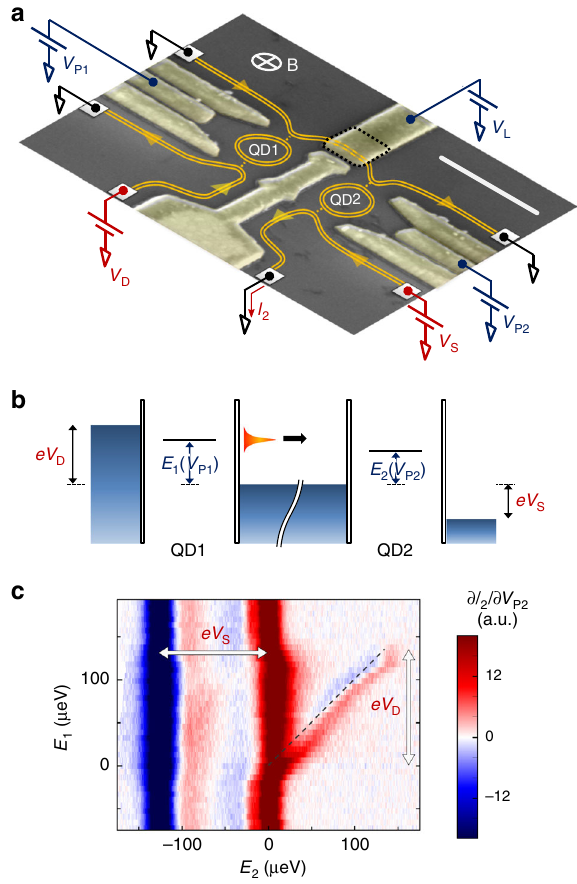
Fig. 1 Principle and implementation of the experiment. a False-color scanning electron micrograph of a typical sample. The ECs at ν = 2 are depicted in orange. The large ohmic contacts located away from the center of the sample are depicted by the gray squares. The white scale bar corresponds to 500 nm. b Energy-scale sketch of the experiment. The two QDs are depicted by a single resonance at energy E 1 ( V P1 ) and E 2 ( V P2 ), respectively. The emitted quasiparticles are depicted by the orange bell- shaped curve. c Raw transconductance ∂ I 2 / ∂ V P2 of the second QD measured as function of E 2 ( V P2 ) ( x -axis) and E 1 ( V P1 ) ( y -axis). The thick vertical (resp. horizontal) arrow indicates the span of the drain (resp. source) potential V D (resp. V S ). The y = x dashed line is a guide for the The devices ’ geometry is depicted in Fig. 1a. The two chiral ECs of ν = 2 are depicted as orange lines. The QDs are de fi ned electrostatically, and can be independently controlled using the plunger gate voltages V P1 and V P2 . Both QDs are tuned to transmit only the outer EC. Quasiparticles in the outer EC stemming from the drain electrode are thus transmitted across the fi rst dot QD1, and propagate along the outer EC connecting the fi rst dot to the second dot QD2. A length gate, controlled by the voltage V L , is used to increase the propagation path by diverting the ECs around the square area delimited by black dashed lines in Fig. 1a (a 200 nm insulating layer of SU-8 resist separates the rest of the gate from the surface of the sample). Several samples have been measured; here we show results obtained on three different devices, with nominal propagation lengths L = 480 nm, L = 750 nm, and 3.4 μ m. Using the length gate on the fi rst two devices yields the additional lengths L ≈ 1.3 μ m (long path for the L = 480 nm device) and L ≈ 2.17 μ m (long path for the L = 750 nm device — see Supplementary Note 1 for details on the devices, including the estimation of the lengths).